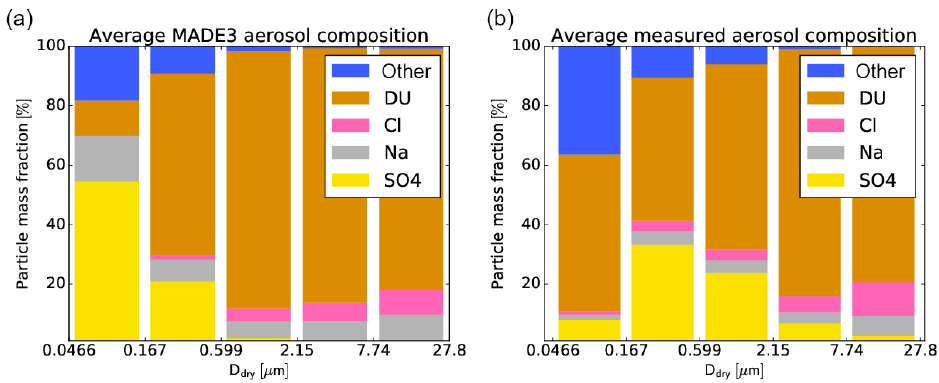
Figure 9. Average size-resolved aerosol composition as simulated by the model (a) and as measured during the SAMUM-2 campaign (b) . Only the mass fractions of species that can be compared between measurement data and model output are depicted.